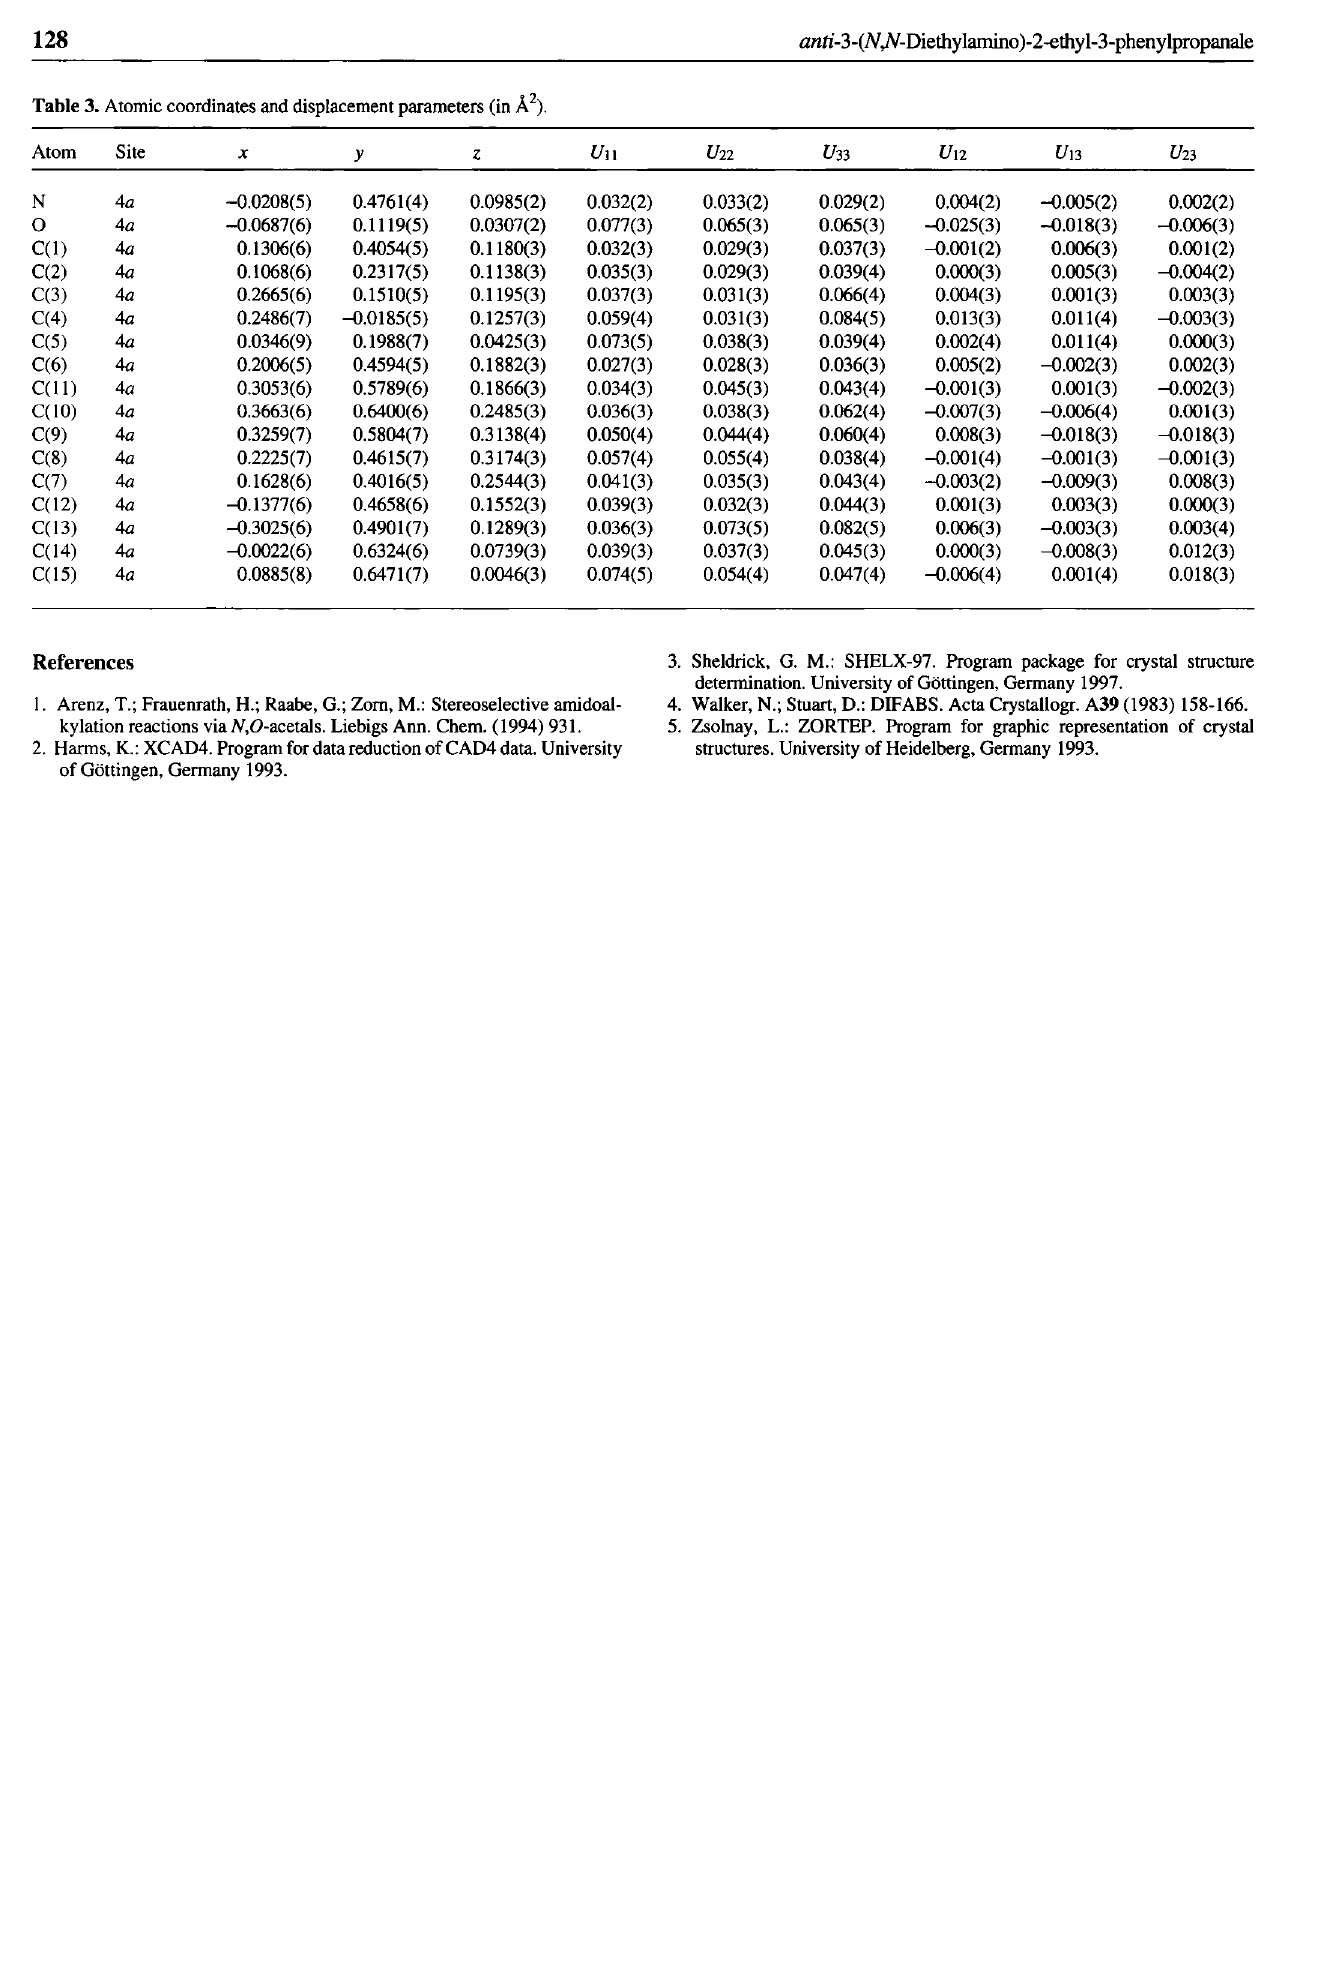
Table 3. Atomic coordinates and displacement parameters (in Â 2